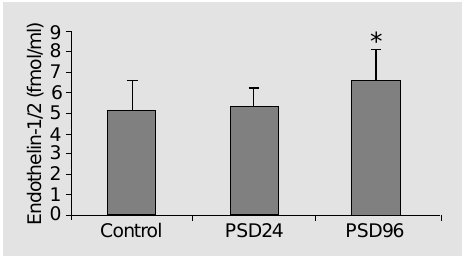
Figure 1. Plasma levels of endo- thelin-1/2 (fmol/ml) after para- doxical sleep deprivation. Values are reported as mean ± SEM. Control (N = 10); PSD24 - para- doxical sleep deprivation for 24 h (N = 10); PSD96 - paradoxical sleep deprivation for 96 h (N = 10). *P £ 0.05 compared to con- trol and PSD24 groups